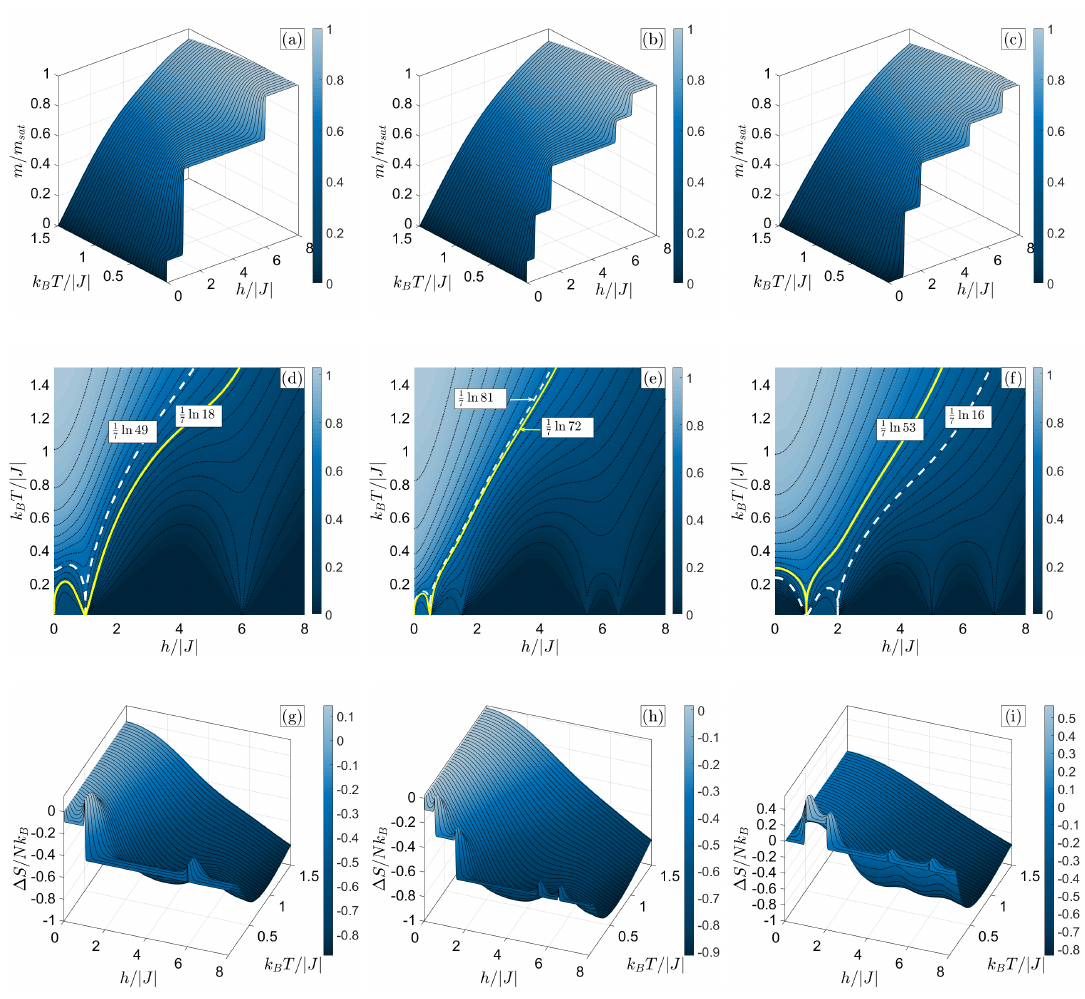
Figure 7. Magnetization ( a – c ), entropy density ( d – f ), and isothermal entropy density change ( g – i ) in k B T / | J | − h / | J | plane, for 2CS cluster with s = 1 and D / | J | = 0 ( a , d , g ), D / | J | = − 0.5 ( b , e , h ), and D / | J | = − 1 ( c , f , i ). The highlighted isentropes in the middle row correspond to the GS residual entropies at the first two critical fields h c 1 / | J | (solid yellow) and h c 2 / | J | (dashed